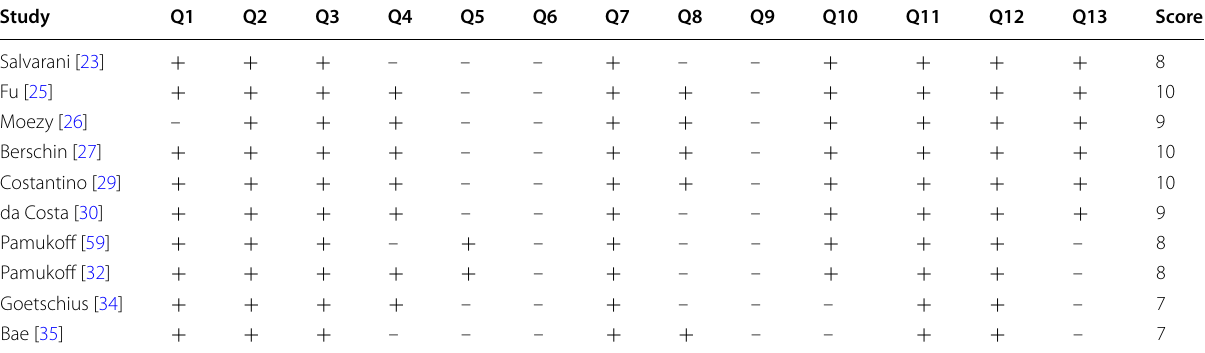
Table 2 Quality of each study’s intervention based on the criteria given by the International Society of Musculoskeletal and Neuronal Interactions (ISMNI) for WBV